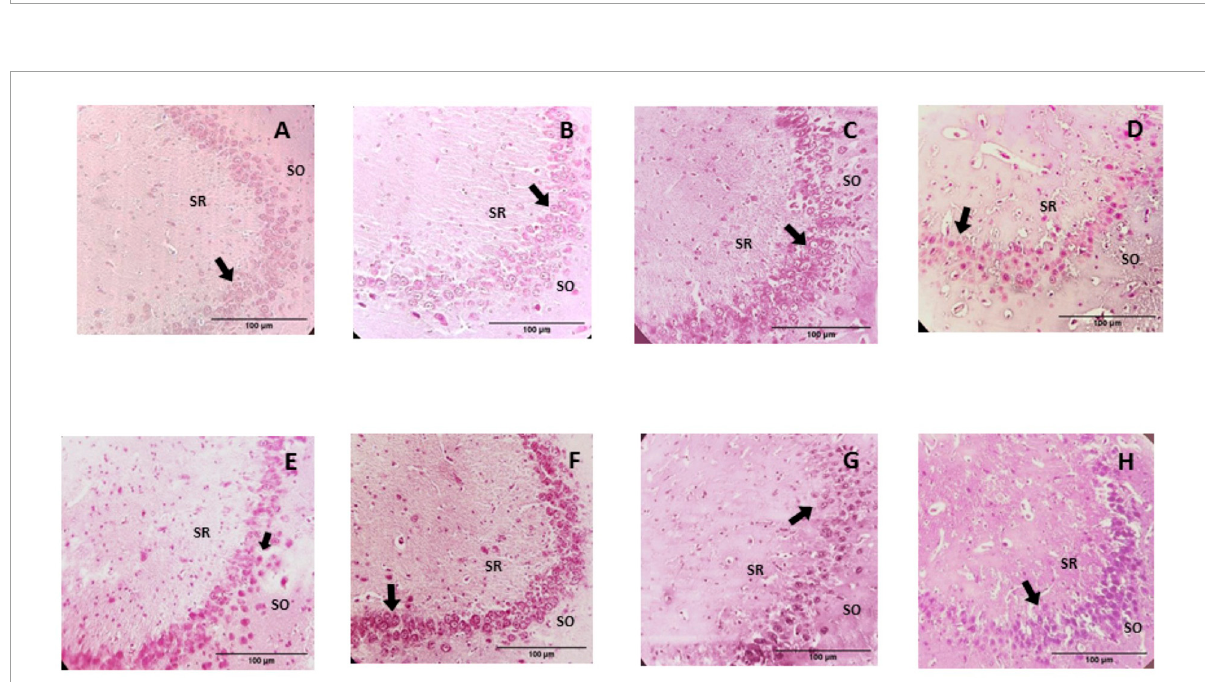
FIGURE8 Photomicrographs of the hippocampal CA3 region from study groups. Prob, probiotics; FO, fish oil; SO, stratum oriens; SR, stratum radiatum. (A) Control, (B) Prob, (C) FO, (D) Prob + FO, (E) chocolate, (F) chocolate + Prob, (G) chocolate + FO, (H) chocolate + FO + Prob. The most important finding in the hippocampal CA3 region was the observation of apparently smaller nuclei in the pyramidal neurons, in addition to a slight basophilia, particularly in the chocolate, chocolate + FO, and FO groups. No damage or degenerative change was observed in any of the groups. Arrows point to neuronal nuclei. H-E Staining. Amplification